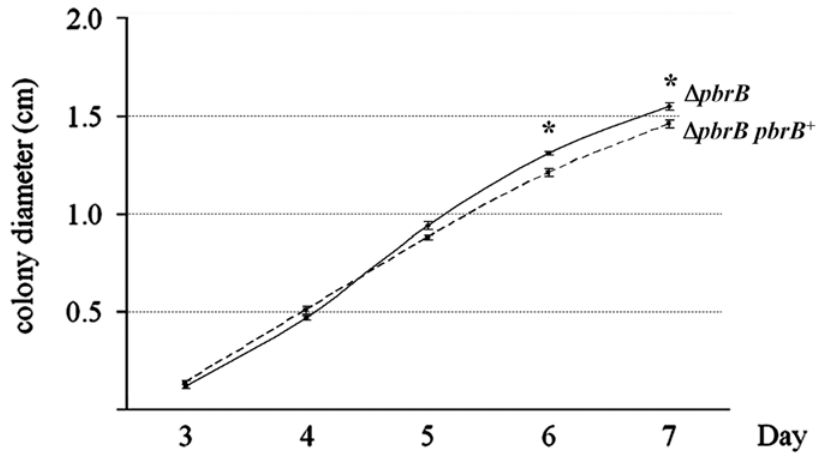
Fig 7. Vegetative growth rate effects in the Δ pbrB mutant. Radial growth rates were assessed by measuring colony diameters for the Δ pbrB and Δ pbrB pbrB + strains growing at 28°C on ANM medium. The line plots the growth rates of Δ pbrB (solid line) and Δ pbrB pbrB + (dashed line). Error bars present standard error of the mean (SEM). Asterisks indicate significantly difference between strains determined by p-values (p = 0.002 and 0.015). X axis is time and Y axis is the mean colony diameter.